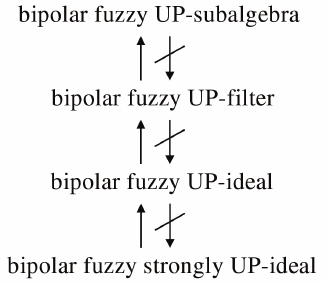
Figure 1. Bipolar-valued fuzzy sets in